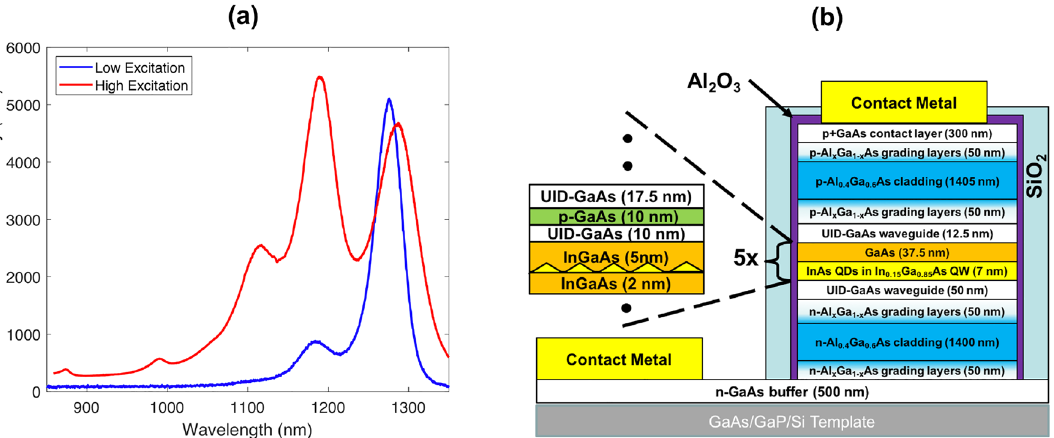
Figure 2: (a) Photoluminescence spectra of an optimized single dot-in-a-well active region at a low pumping level (blue curve) and high pumping level (red curve); (b) Schematicillustration of the p-doped QD laser epitaxial structure. The close-up on the left depicts one period of the active region.